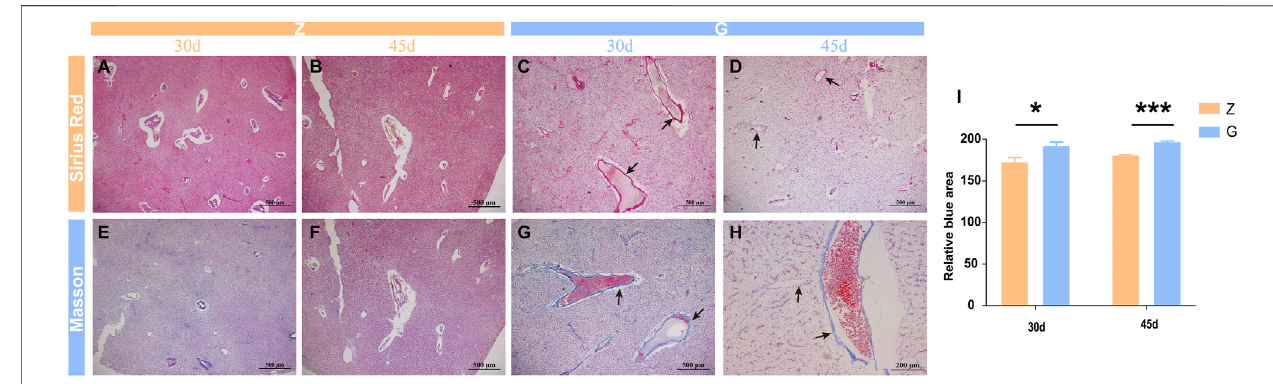
FIGURE 4 | Sirius red and Mosson staining in largemouth bass liver. (A – D) Sirius red staining fi broblasts stain red (arrow). (E – H) Mosson staining; fi broblasts stain light blue (arrow). (I) Relative quantitative analysis of Mosson staining (* p < 0.05, *** p <